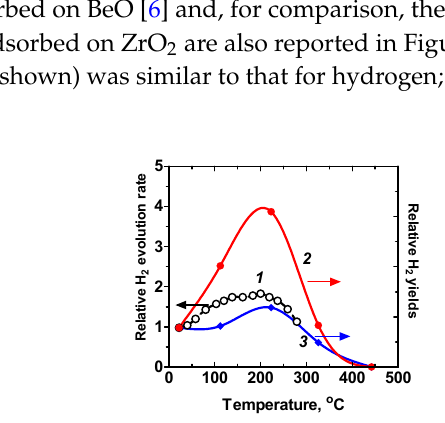
Figure 3. Temperature dependences of the relative rate of hydrogen evolution (curve 1 ) during the photolysis of adsorbed water on BeO (water vapor pressure = 2 × 10 2 Pa); the temperature dependence of oxygen evolution was similar to that for hydrogen; the gases H 2 and O 2 evolved in amounts close to stoichiometric [5]. The relative hydrogen yields in the radiolysis of water on ZrO 2 at 2.8 MeV electrons (curve 2 ) and at 5.0 MeV He 2+ ions (curve 3 ) are also displayed. Curves 2 and 3 were adapted with permission from Roth et al. J. Phys. Chem. C 2012 , 116 , 1719 [36]. Copyright 2012 American Chemical Society.